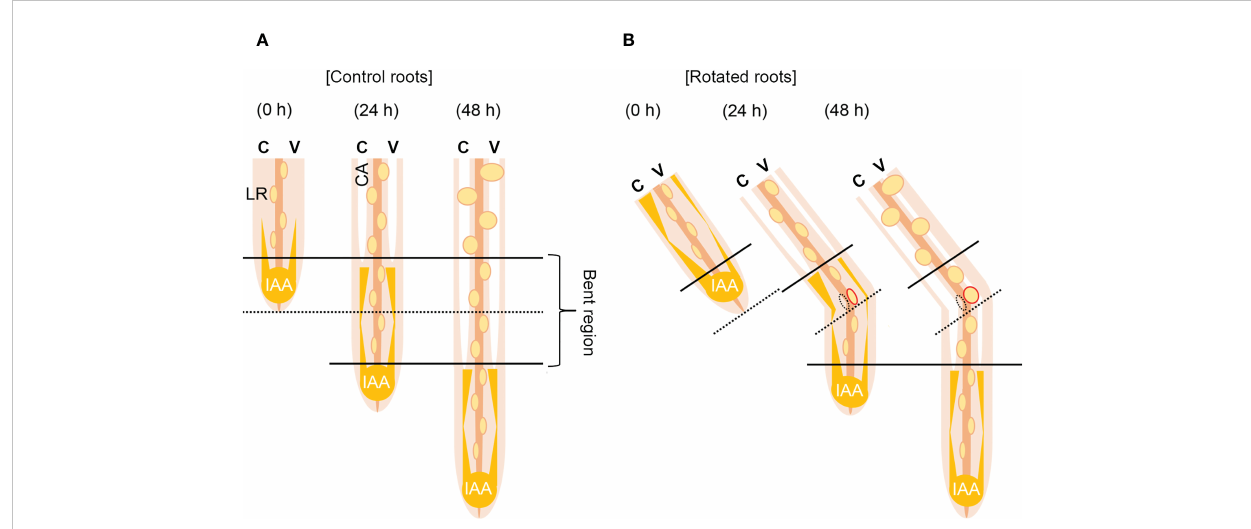
FIGURE 7 Model of contrasting aerenchyma formation regulated by asymmetric auxin distribution in the cortex of the gravity-stimulated nodal roots of Z. nicaraguensis . (A) Lateral root (LR) and constitutive aerenchyma (CA) formation is symmetric in the control. In the cortex, longitudinal gradients of auxin stimulate CA formation. (B) LR and CA formations are asymmetric under the gravistimulation treatment. Auxin levels increase and decrease in the cortex on the concave and convex sides, respectively. Thus, CA formation is accelerated on the concave side and retarded on the convex side of the nodal roots. By contrast, a transient increase in the auxin level on the convex side of the pericycle promotes LR formation. C; concave side, V; convex